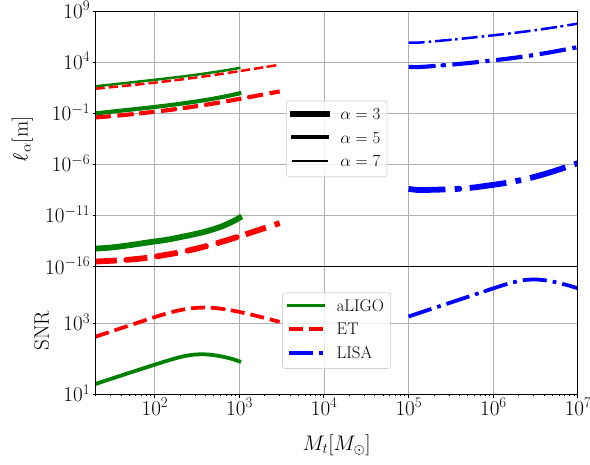
Fig. 1 The upper limits on the CPT-violating parameter (cid:4) α ( α = 3 , 5 , 7) from aLIGO (green solid), ET (red dashed), and LISA (blue dash-dotted). The SNRs are also obtained for the three detectors here